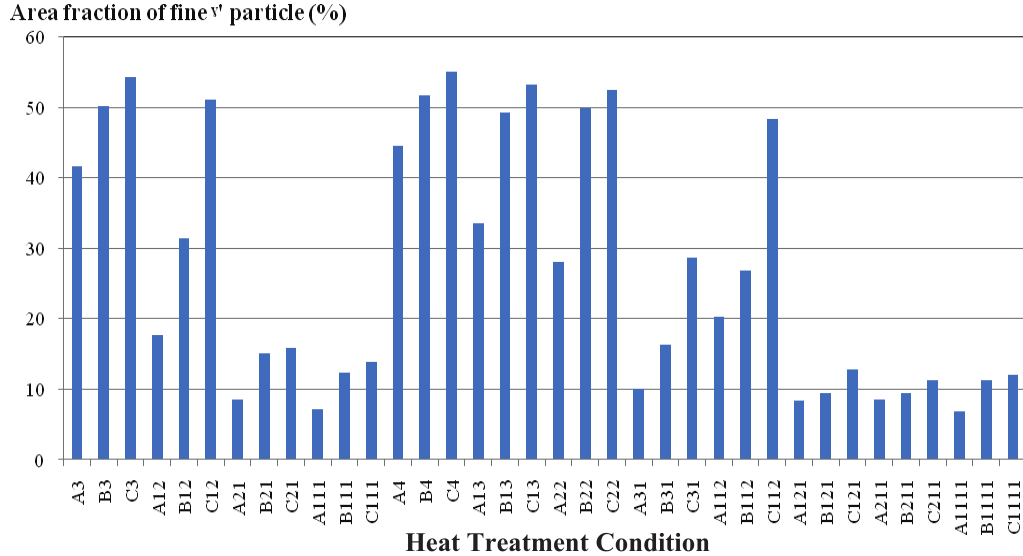
Figure 28. The relationship between heat treatment condition and area fraction of fine (cid:2) 0